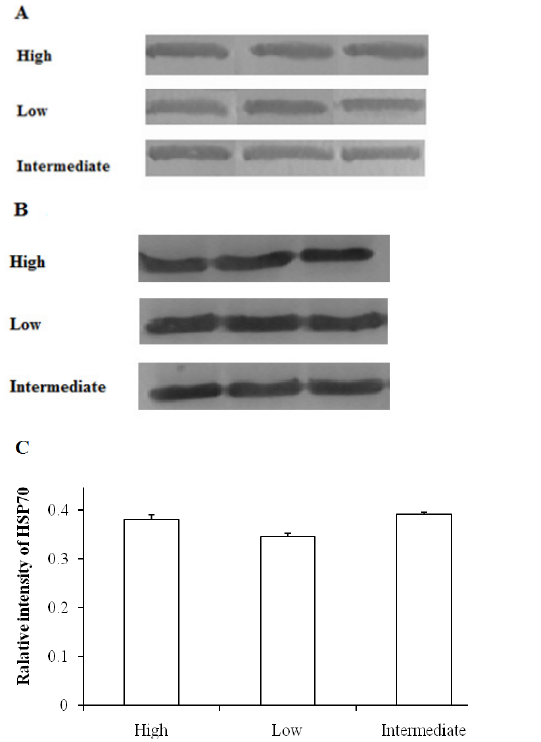
Figure 2. Western blot of heat shock protein (HSP) 70 (A), glyceraldehyde-3- phosphate dehydrogenase (B) in high (n = 6), intermediate (n = 6) and low (n = 6) drip loss grouped chicken muscles, and relative intensities of HSP70 (C). Error bars are standard error of the mean.